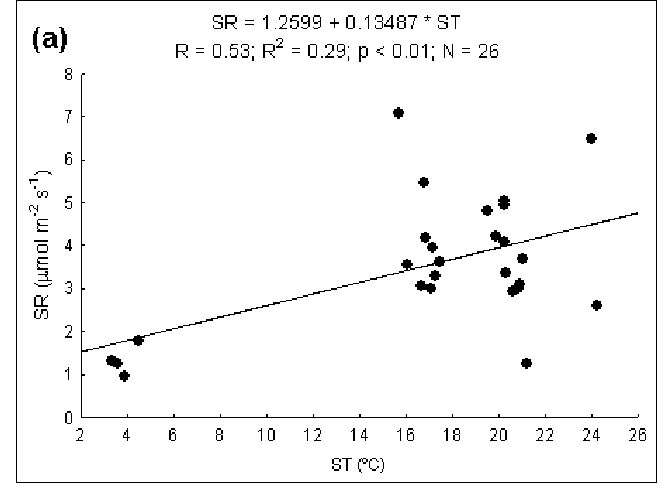
FIGURE 3. The relationships between soil respiration, soil temperature, and soil volumetric water content during the experimental period in the Quercus (a), Quercus-Pinus (b), and Pinus (c) stands at Valsaín